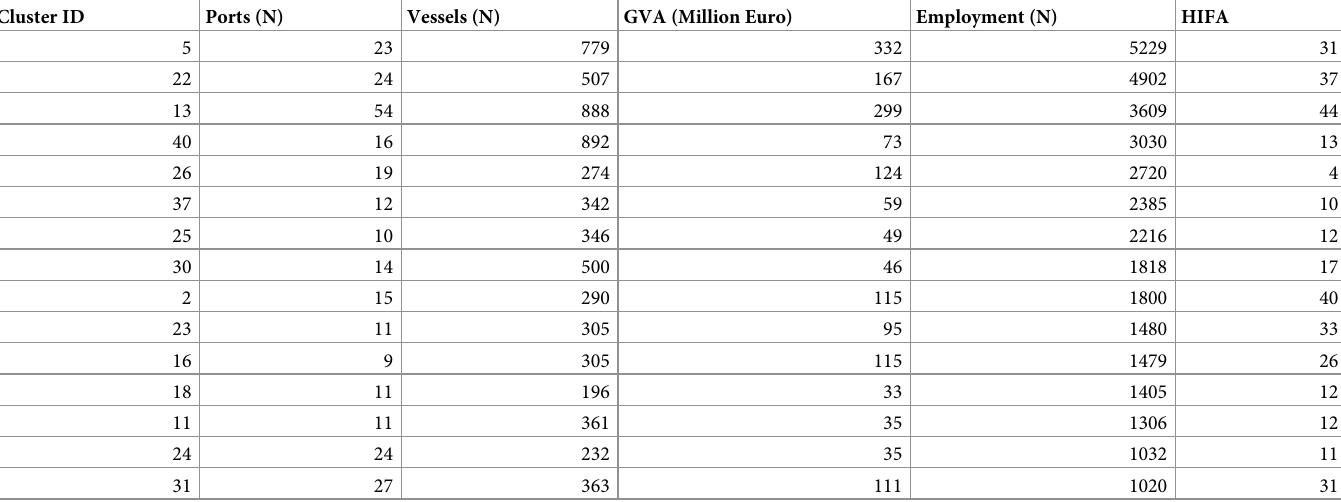
Table 1. Descriptive statistics for the top 15 port–HIFA clusters on the basis of total employment. Cluster ID Ports